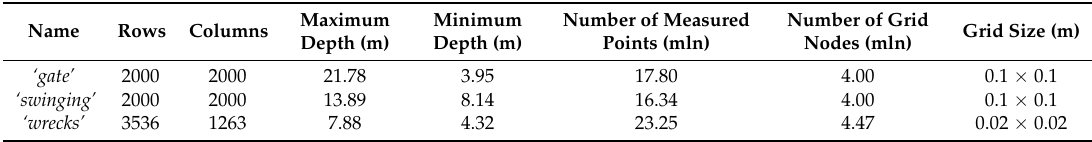
Table 1. Sizes of tested